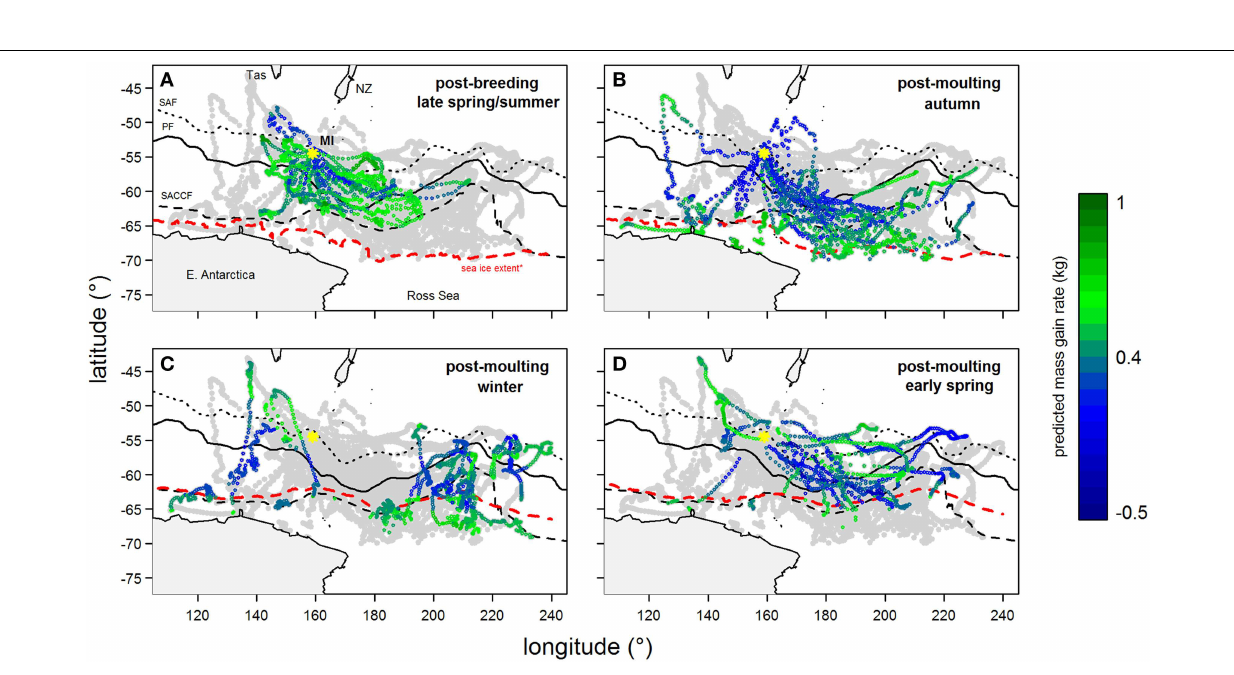
(NZ, top) and the coast of East Antarctica and Ross Sea (bottom). The yellow asterisk indicates Macquarie Island (MI). Three major fronts are also shown: sub-Antarctic Front (SAF—dotted); Polar Front (PF—solid); and Southern Antarctic Circumpolar Current Front (SACCF—dashed). The seasonal sea ice extent (red dashed line) is defined as the northern boundary where average sea ice concentration between 1999 and 2005 is >